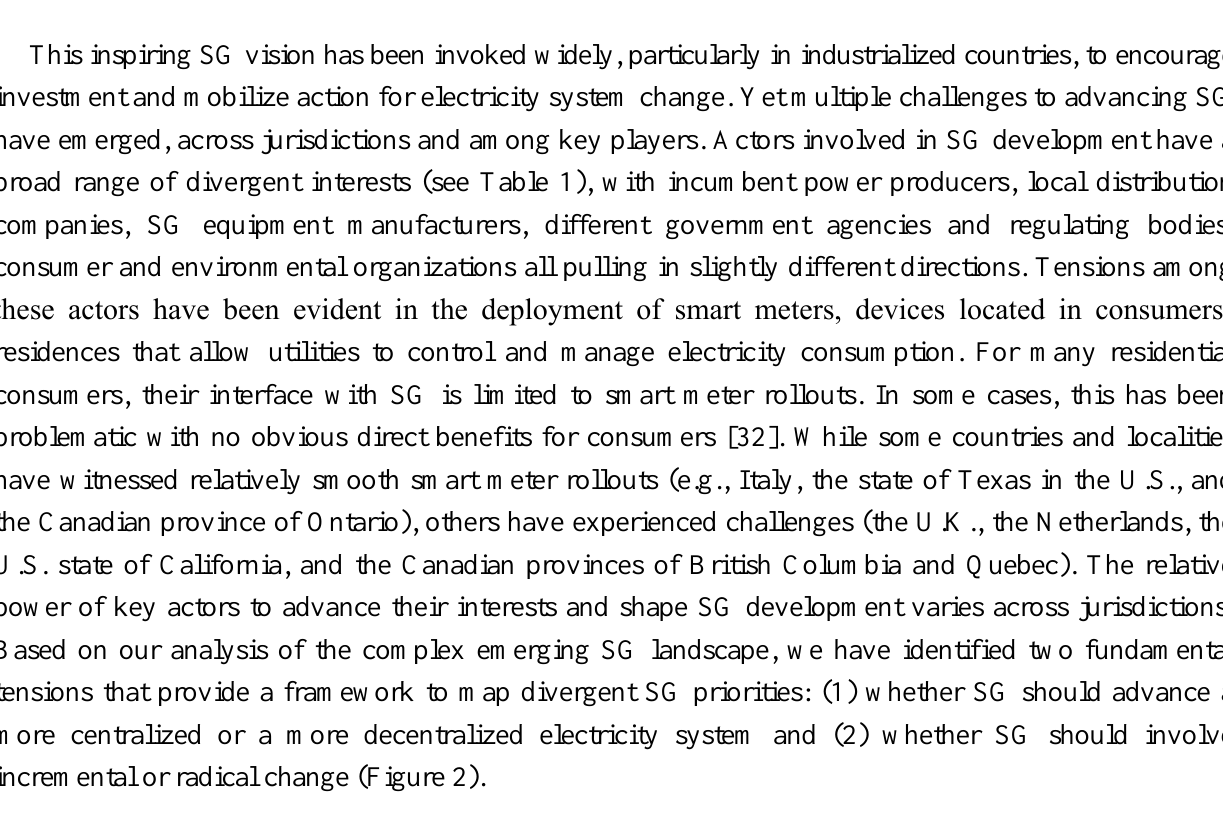
Table 1. Priorities, perspectives, and tensions associated with key actors involved in creating a smarter